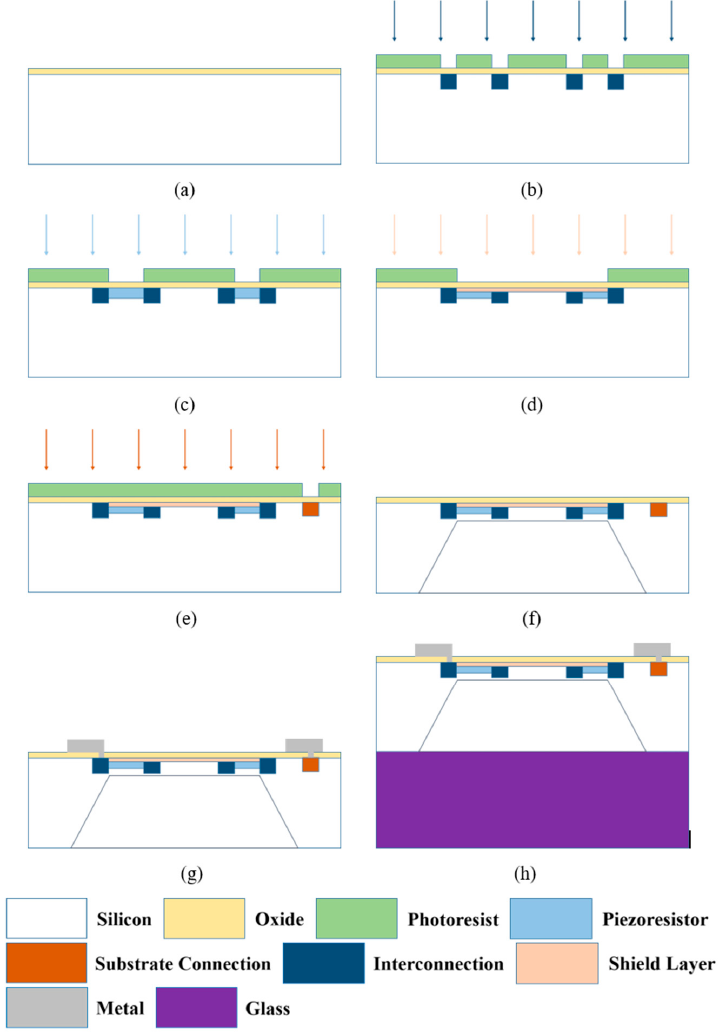
Figure 2. Process flow of the pressure sensor with a shield layer ( a – h ).